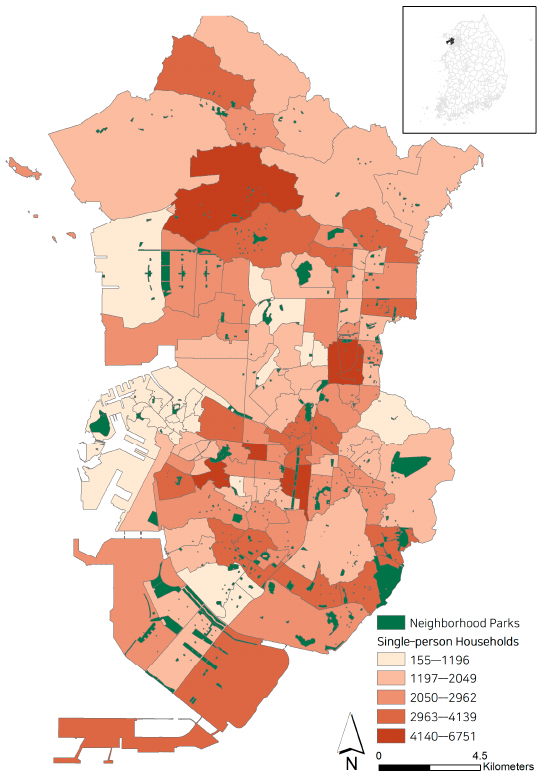
Figure 1. Study Area and the Distribution of Single-person Households in Inland Incheon.